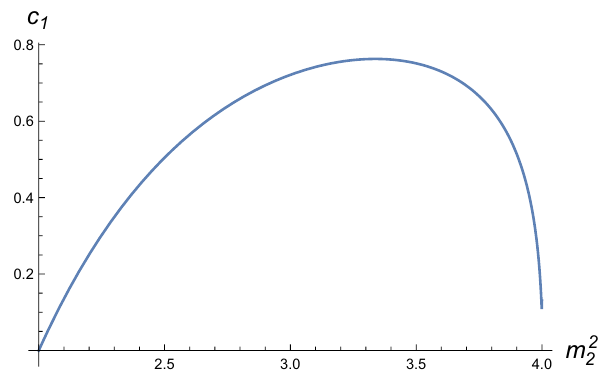
Figure 1 . Contribution of the one particle states of the second breather into the UV central charge as a function of m 2 . On the horizontal axis the mass m 2 is given in the units of m 1 . The range of 2 parameters which allow for the existence of the second breather is provided in (4.17). For m 2 we have c 1 0 : (cid:25)